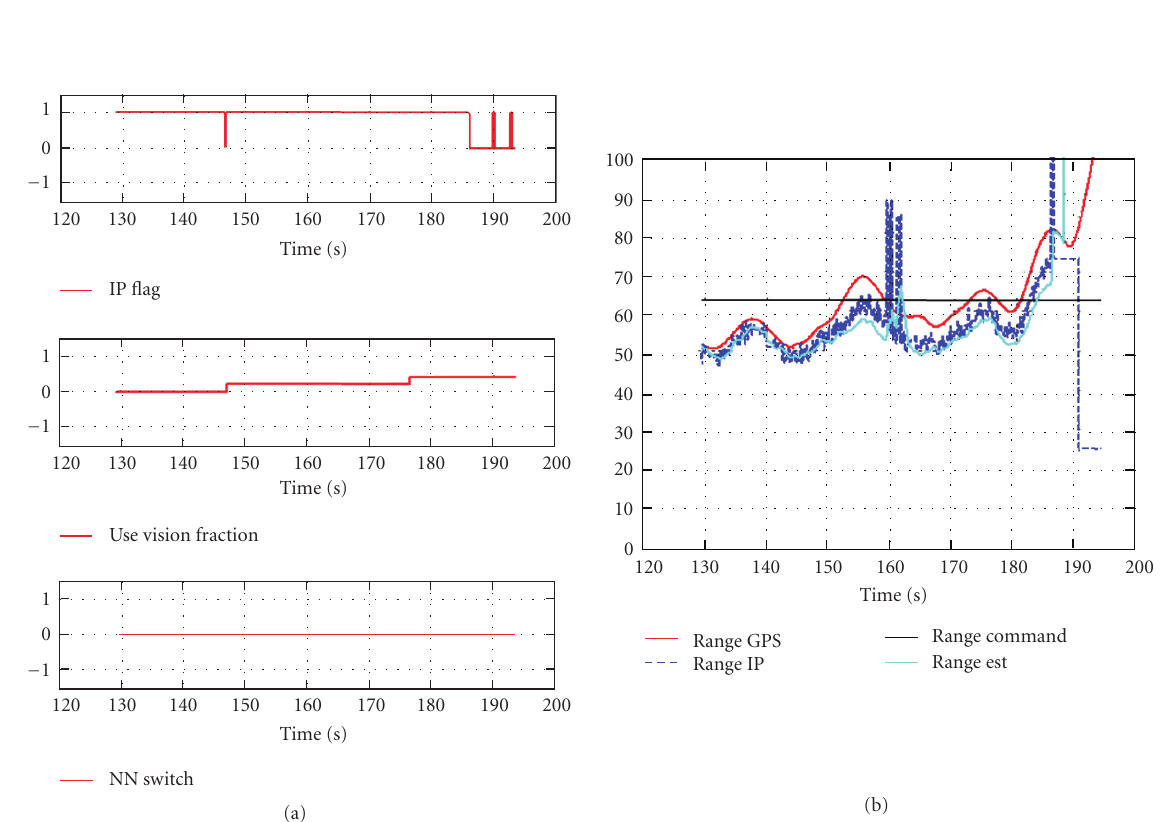
Figure 10: Adaptive estimation simulation results.